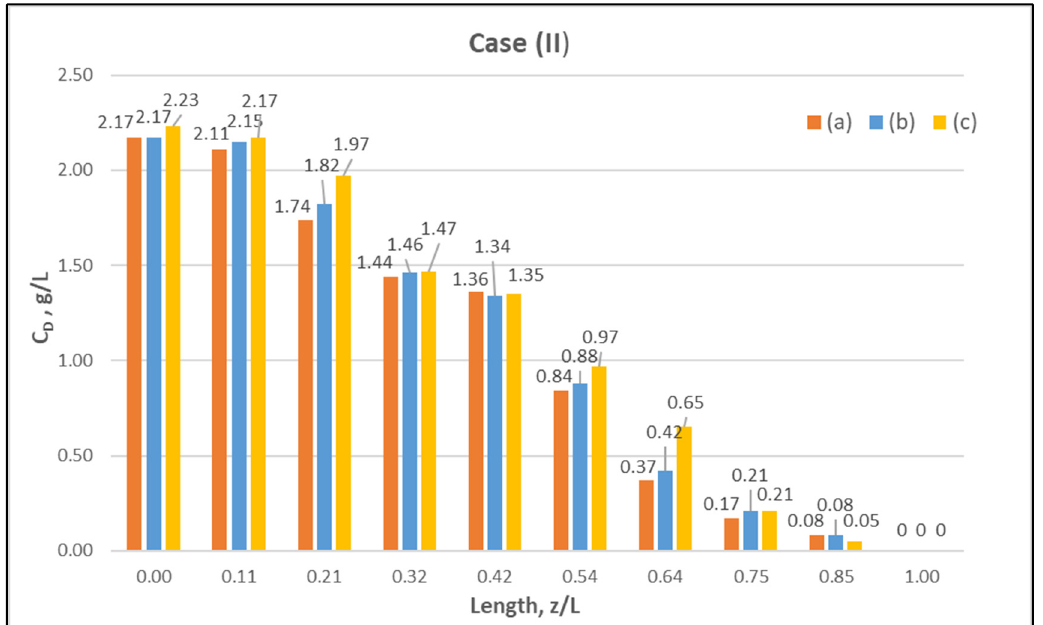
Figure 7. Measured (in triplicate) local urea concentration in the shell side of the module. Case (II): flow rates Q Blood = 250 mL/min, Q Dialysate = 400 mL/min.